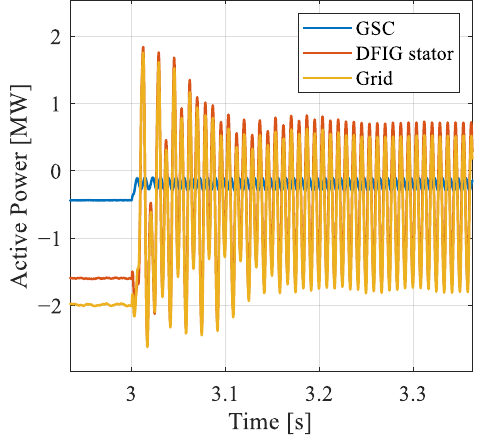
Figure 12. DFIG currents for an unbalanced voltage sag of 20%: ( a ) stator currents and ( b ) rotor currents.